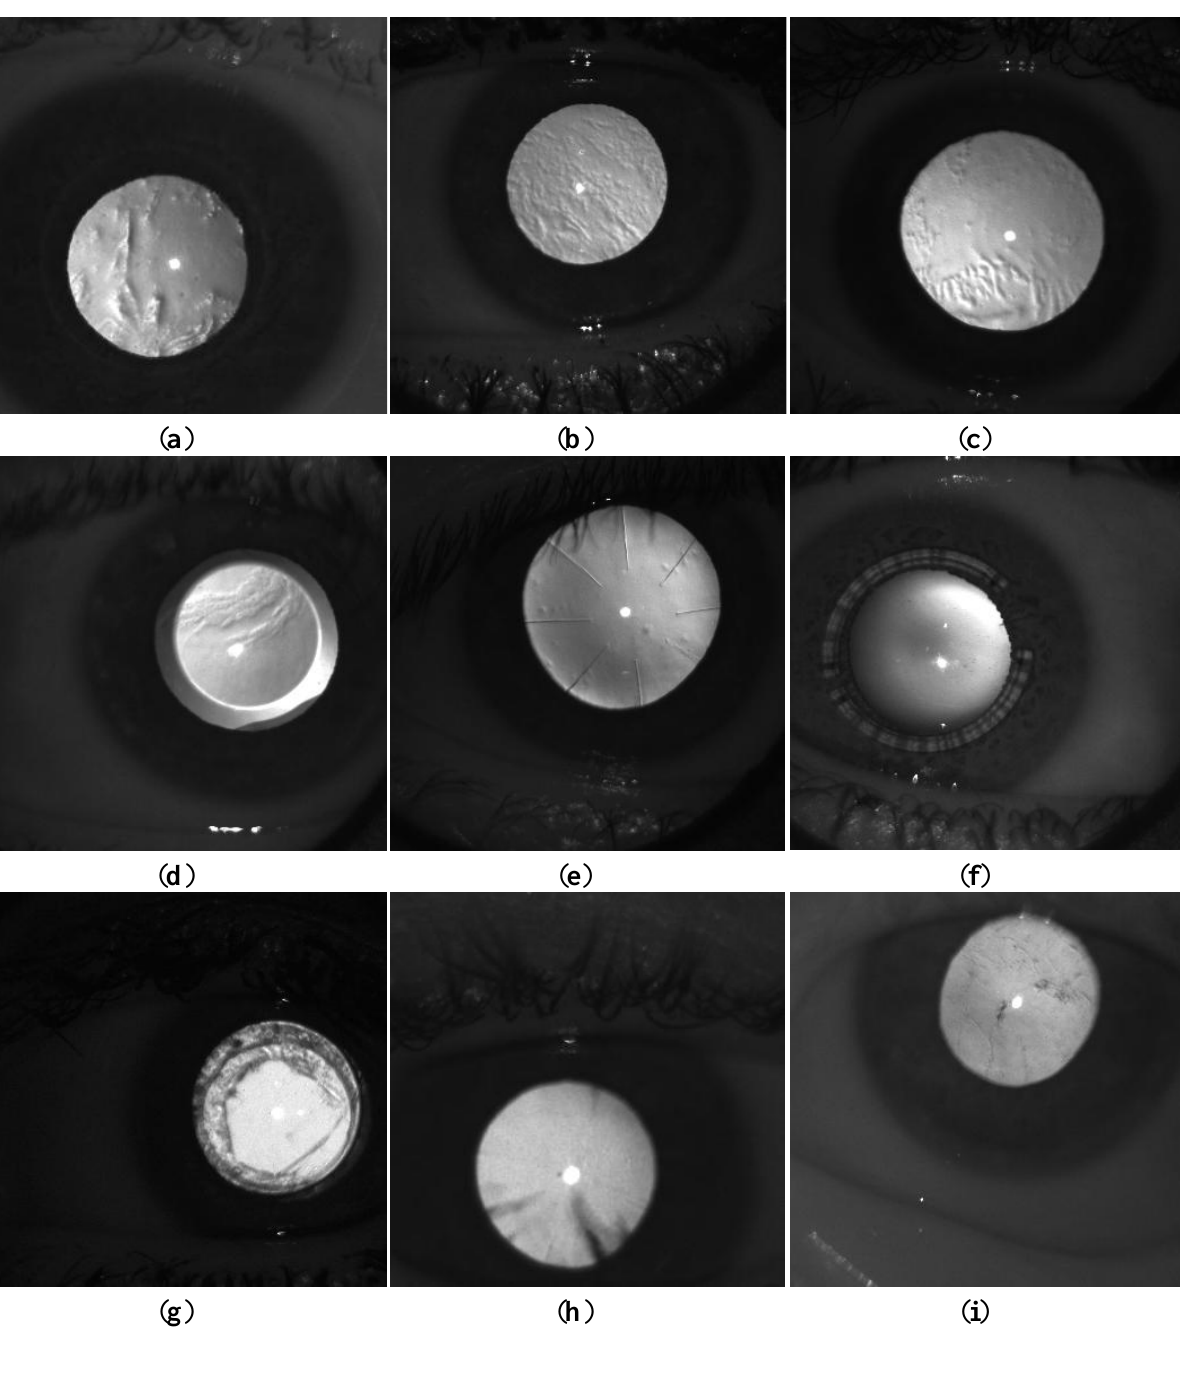
Figure 4. ( a ) An image of an eye of a long-term contact-lens wearer. The image was taken shortly after the daily wear contact lens was removed. ( b ) Tear-film breakup image of a normal eye. ( c ) Image from a dry eye patient. (d) Image of a healthy eye with implantable contact lens. Tear-film breakup is also observed. ( e ) Image from a healthy eye with PK performed 24 years before. ( f ) Image of a keratoconus eye 16 days after Intacs surgery. ( g ) Image of an eye with anterior basement membrane dystrophy (ABMD). ( h ) Image of an eye with mild cortex cataract. ( i ) Image of an eye with Fuch’s endothelium dystrophy. In each image, the white dot near the center of pupil reflex is the corneal reflection, the first Purkinji